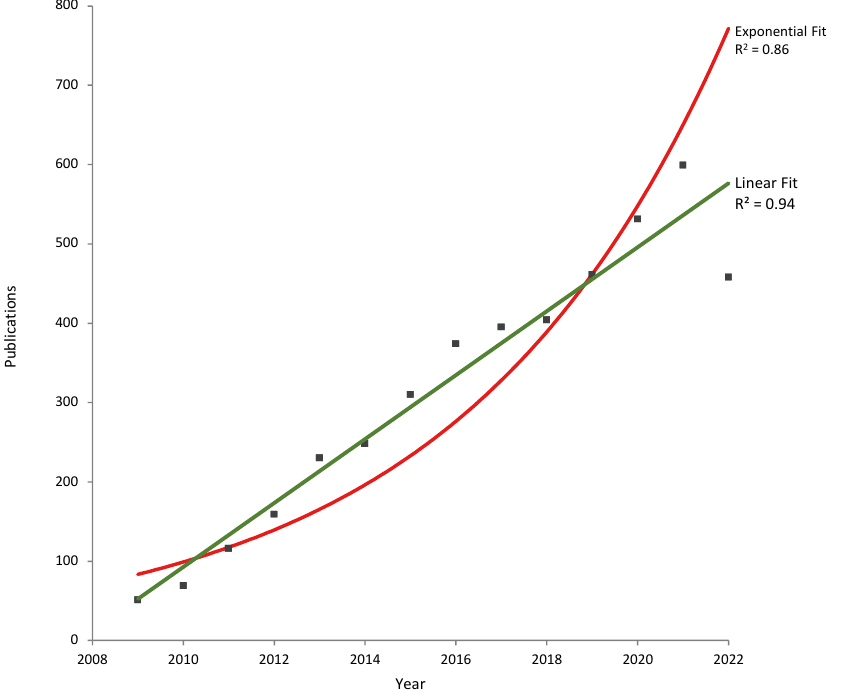
Figure 1. Publications listed per year in PubMed for the search term high-sensitivity cardiac troponin from 2009 to 2022 (search date 9 December 2022).